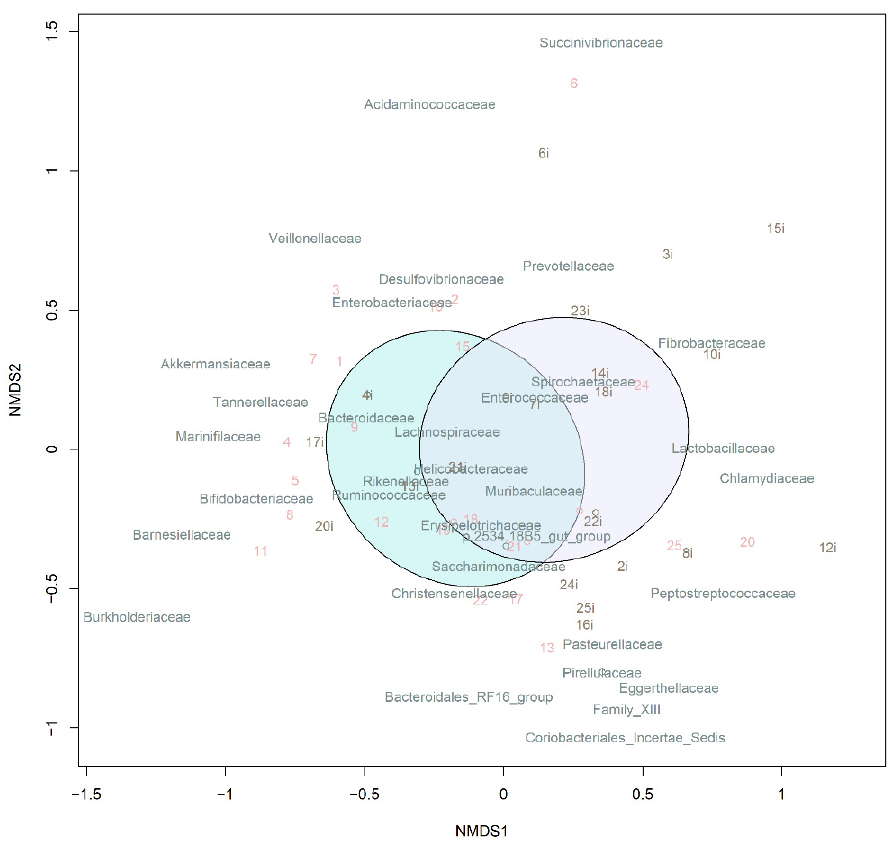
Figure 8. NMDS of beta-diversity in the samples. Ellipsoids correspond to 95% confidence intervals. Note: The purple and blue ellipsoids show the microbiome before and after the TBI, respectively.